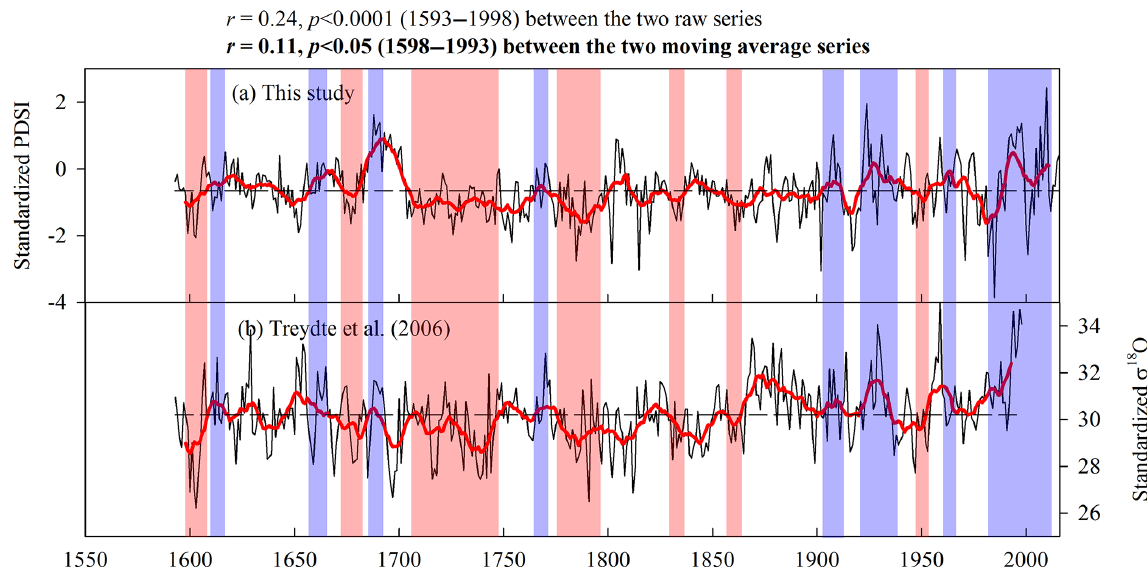
Figure 6. Comparison of our PDSI reconstruction (a) with the precipitation reconstruction (reversed tree-ring δ 18 O) of Treydte et al. (2006) (b) in northern Pakistan. Purple and brown shaded areas represent the consistent wet and dry periods in the two reconstructions, respectively. The two correlation coefficients ( r = 0 . 24 and r = 0 . 11) are the correlations of two original annual-resolution reconstruction series and two 11-year moving average series,